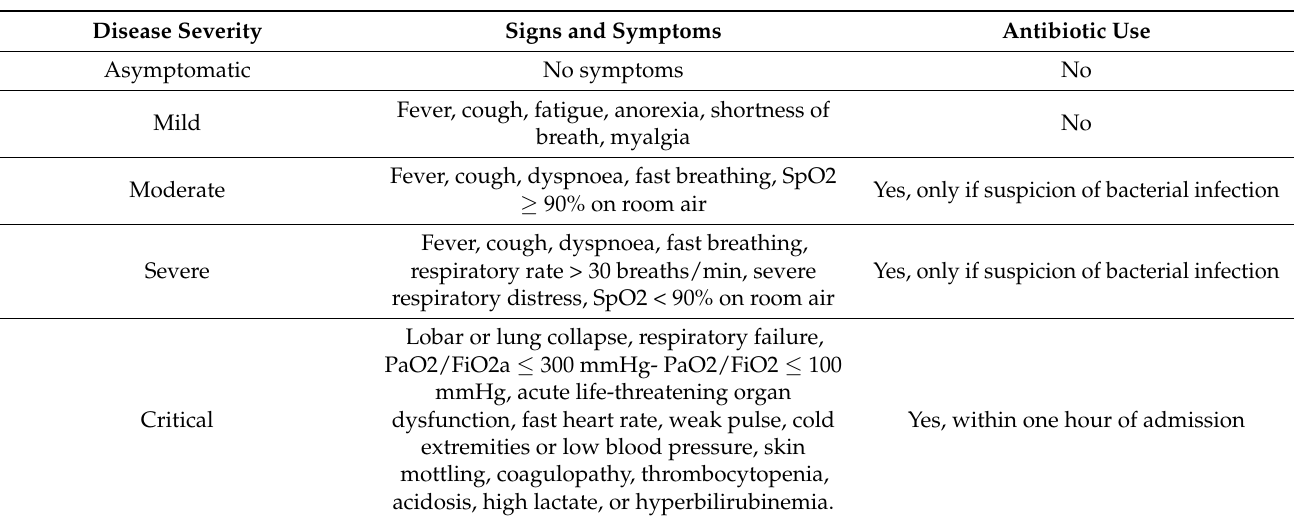
Table 1. COVID-19 disease classification, signs and symptoms, and antibiotic use according to the 2020 WHO clinical management